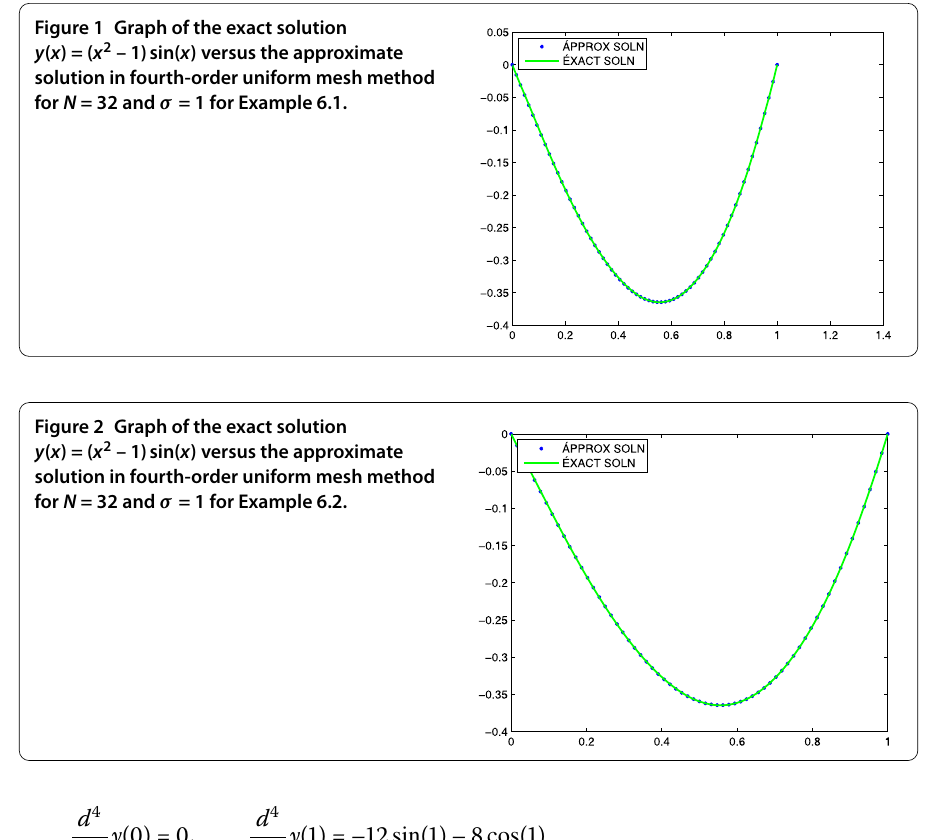
Figure 1 Graph of the exact solution y ( x ) = ( x 2 – 1)sin( x ) versus the approximate solution in fourth-order uniform mesh method for N = 32 and σ = 1 for Example 6.1.